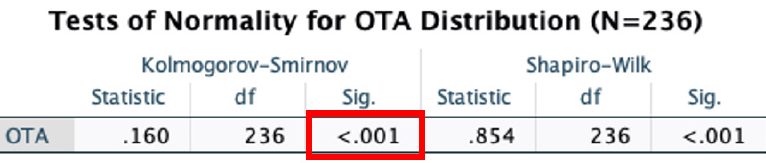
Figure 6. Kolmogorov-Smirnov normality test showed no significance ( p < 0.001) for fit of normality of OTA distribution in urinalysis of ME/CFS patients.